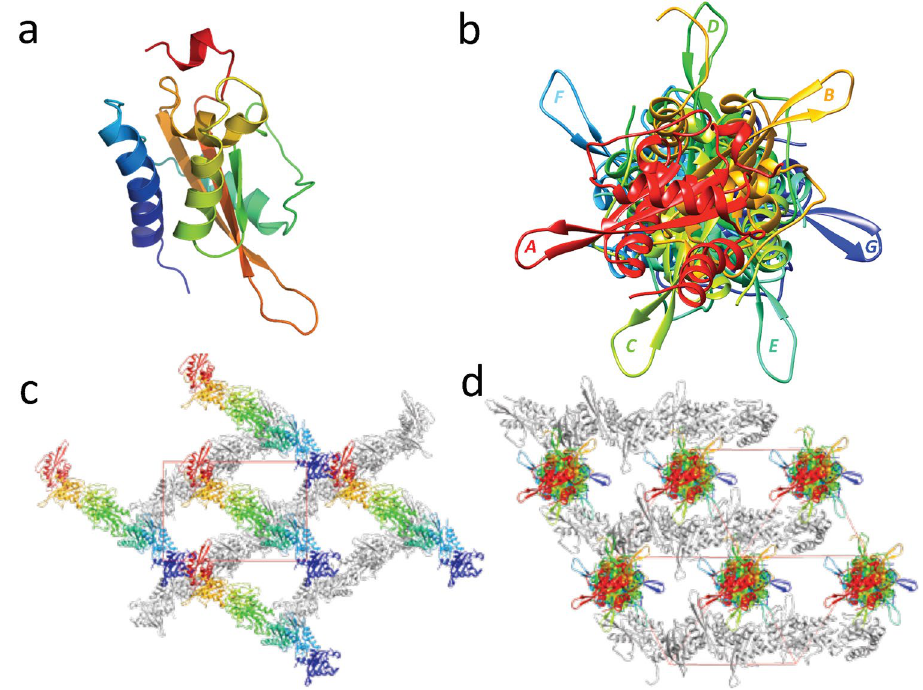
Figure 1. Crystal structure and packing of MpPR-1i. ( a ) Cartoon of monomer A colored in rainbow from blue (N-ter) to red (C-ter). ( b ) MpPR-1i monomers in asymmetric unit viewed along the diagonal of unit cell shows a pseudo-seven fold screw axis; each monomer is labeled along the direction of (110) to (011) as A, B, C, D, E, F, and G respectively. ( c ) Crystal packing presented along a cell dimension. Monomers in the top layer are colored as in Fig. 1b, while the bottom layer monomers are shown in gray. The large solvent channel formed by crystal packing is also visible. ( d ) Crystal packing viewed along the cell